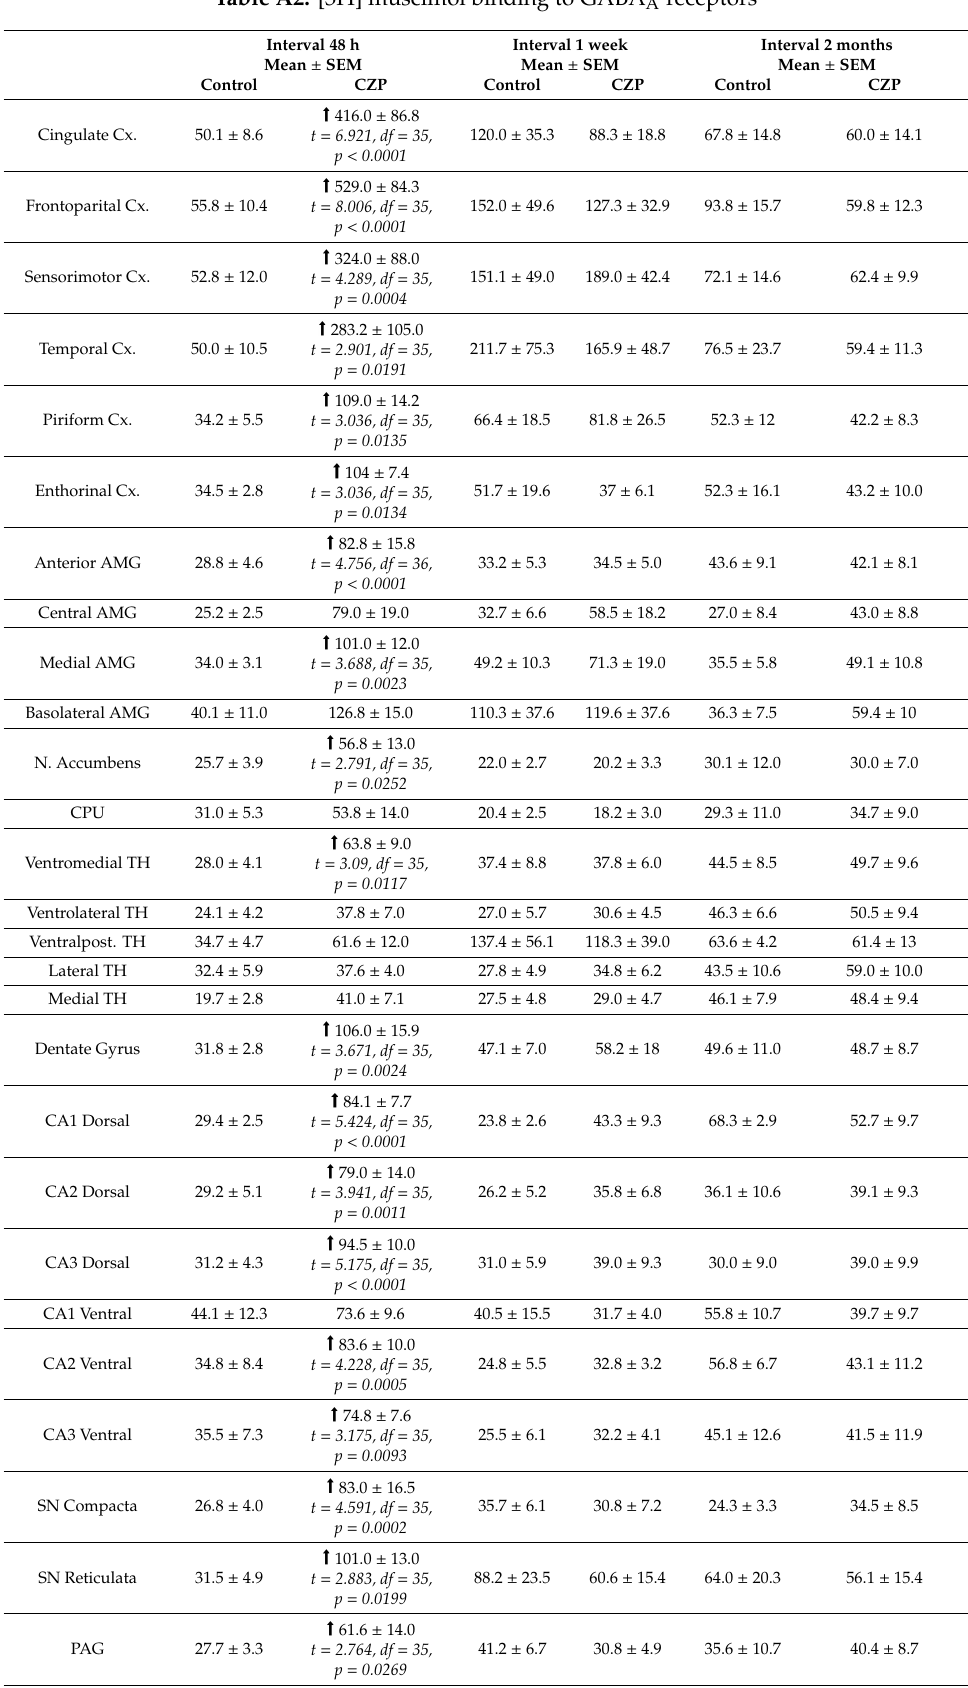
Table A2. [3H] muscimol binding to GABA A